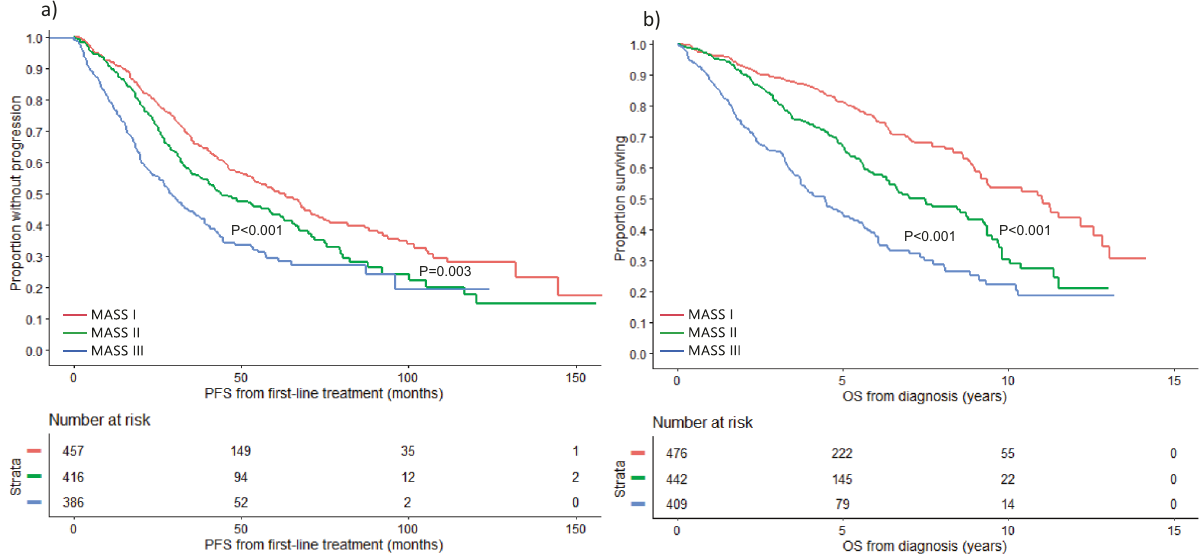
Fig. 2 PFS and OS based on the MASS using the Mayo Clinic cohort. a PFS (months) and b OS (years) in MM patients with no HR factors (stage I) (red curve), 1 HR factor (stage II) (green curve), and ≥ 2 HR factors (stage III) (blue curve). HR factors are de fi ned as any of: HR IgH translocations, 1q gain/ampli fi cation, chromosome 17 abnormality [(del)17p/monosomy 17], ISS stage III, and LDH > ULN. del : deletion, HR : high-risk, IgH immunoglobulin heavy chain gene locus, ISS international staging system, LDH lactate dehydrogenase, MASS Mayo Additive Staging System, MM multiple myeloma, OS overall survival, PFS progression-free survival, ULN upper limit of normal. The P values for each pair of groups are presented between the corresponding curves.